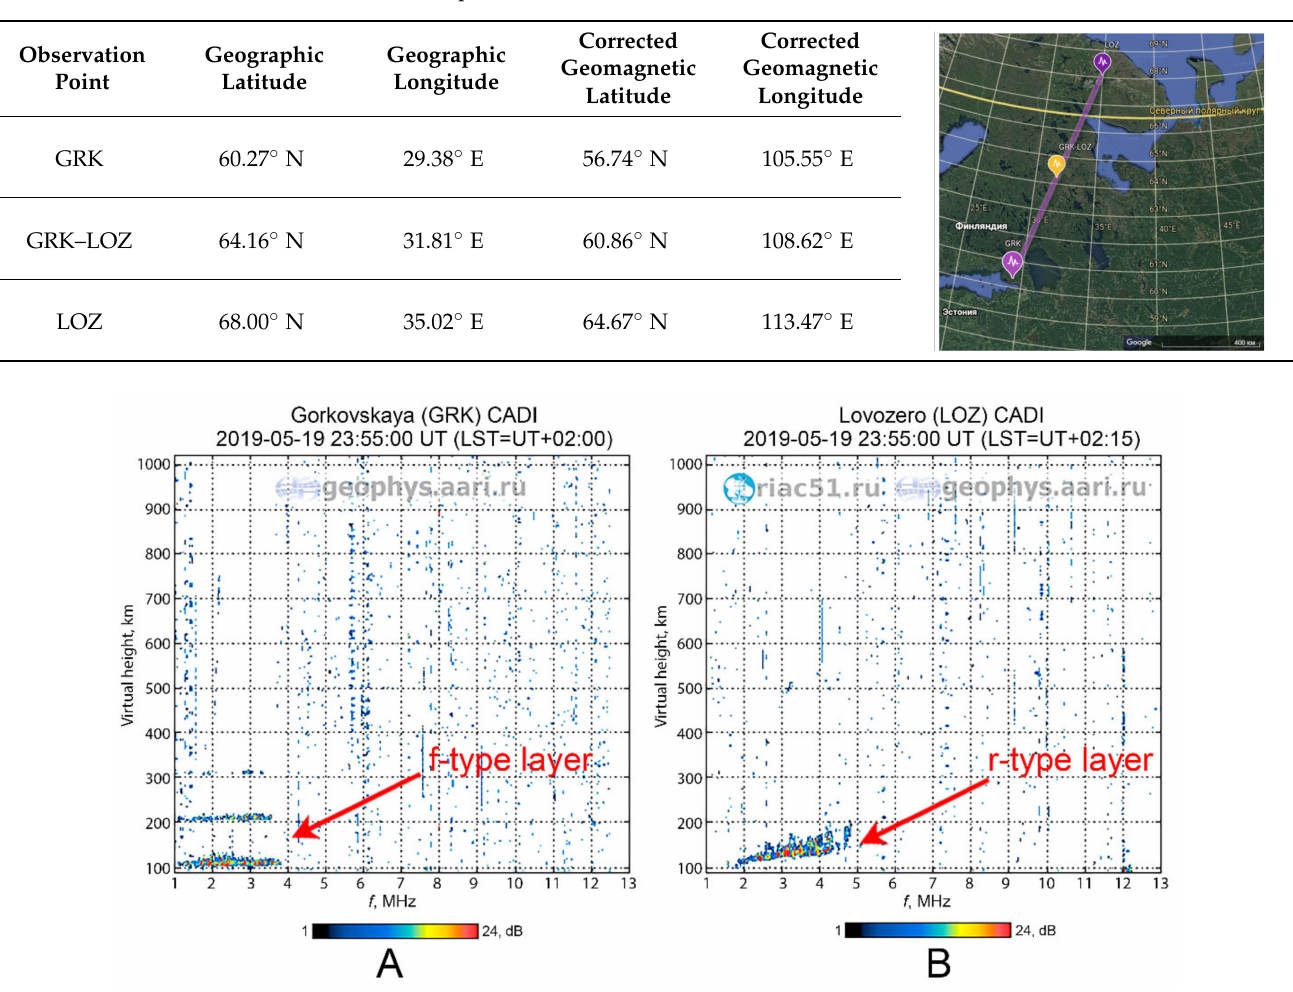
Table 1. Geographic and corrected geomagnetic coordinates of Gorkovskaya (GRK), Lovozero (LOZ) stations, and the central point of the Gorkovskaya–Lovozero (GRK–LOZ) radio path, and a map with measurement points.